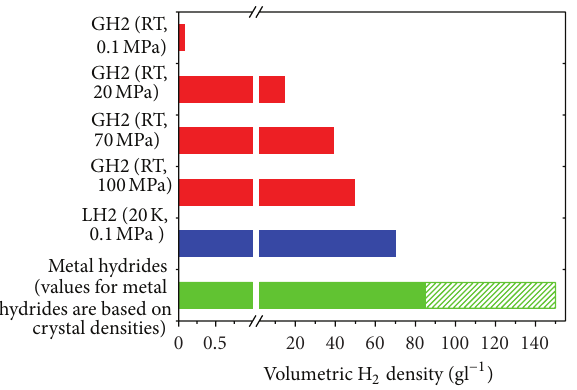
Figure 7: Comparison of volumetric fuel densities for different hydrogen storage technologies: compressed hydrogen (GH2) at room temperature for 0.1, 20, 70, and 100MPa [36]; liquid hydrogen (LH2); and metal hydrides